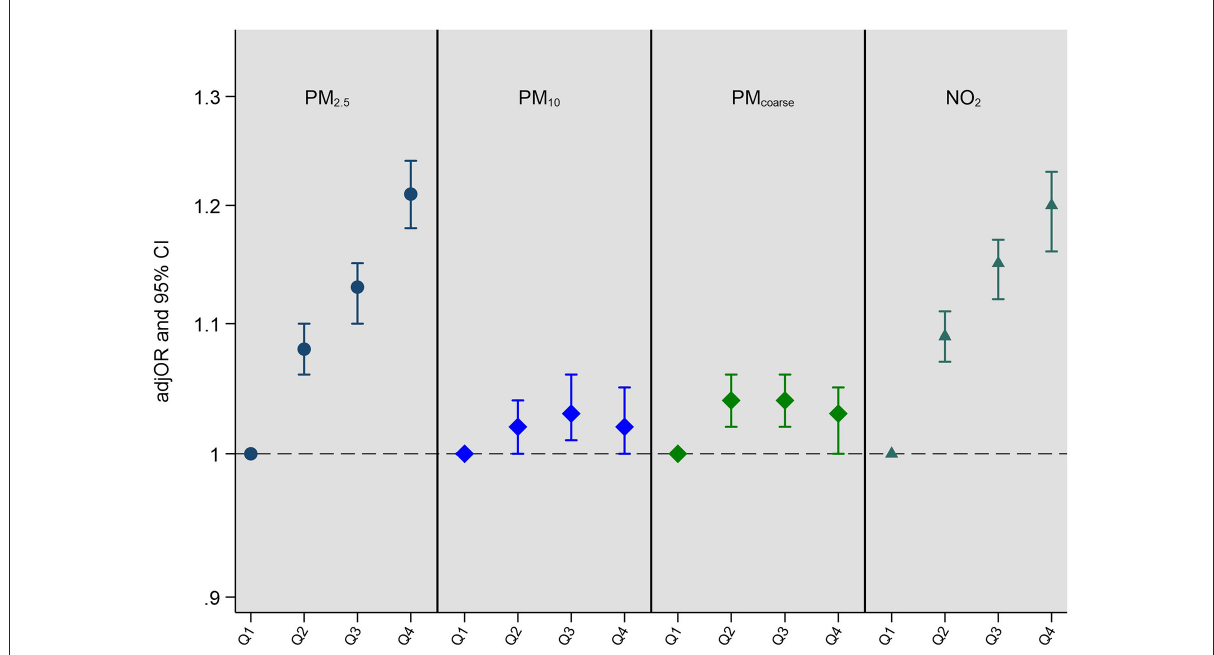
FIGURE1 Adjusted odds ratios (adjOR) and their corresponding 95% confidence intervals (CI) from ordinal regressions looking at associations between exposure to air pollution (PM 2.5 , PM 10 , PM coarse , and NO 2 ) and multimorbidity status ( N = 364,144). Air pollutants ( µ g/m 3 ) are categorized as quartiles in order to assess dose response associations, with the lowest quartile (Q1) acting as the reference quartile. All models are adjusted for age, sex, ethnicity, education level, employment status, household income, smoking status, alcohol intake frequency, BMI, physical activity, nearest major road, traffic intensity on nearest major road, residential green space (1,000m) and 24h noise pollution (Lden). The quartile cut-offs for NO 2 were: Q1 < 21.32 µ g/m 3 , Q2 < 26.09 µ g/m 3 , Q3 < 31.22 µ g/m 3 and Q4 ≥ 31.22 µ g/m 3 ; for PM 2.5 they were: Q1 < 9.29 µ g/m 3 , Q2 < 9.93 µ g/m 3 , Q3 < 10.56 µ g/m 3 and Q4 ≥ 10.56 µ g/m 3 ; for PM coarse they were: Q1 < 5.85 µ g/m 3 , Q2 < 6.11 µ g/m 3 , Q3 < 6.63 µ g/m 3 and Q4 ≥ 6.63 µ g/m 3 ; and for PM 10 they were: Q1 < 15.24 µ g/m 3 , Q2 < 16.03 µ g/m 3 , Q3 < 16.99 µ g/m 3 and Q4 ≥ 16.99 µ g/m 3 . P values for trend for each air pollutant are as follows: PM 2.5 : p < 0.001; PM 10 : p = 0.002; PM coarse : p = 0.300; NO 2 : p <